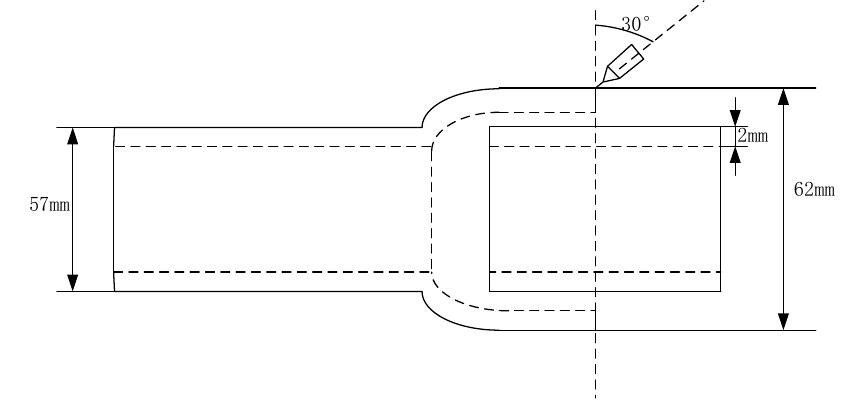
Figure 2. The schematic diagram of the lap joint. Table 1. Chemical compositions of parent metal (wt%).